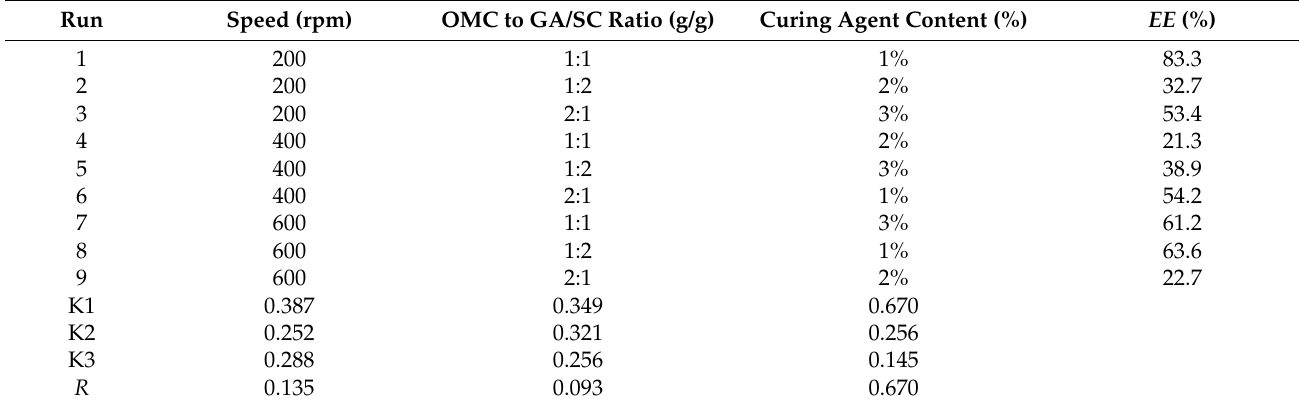
Table 4. Factors and levels of the OMC